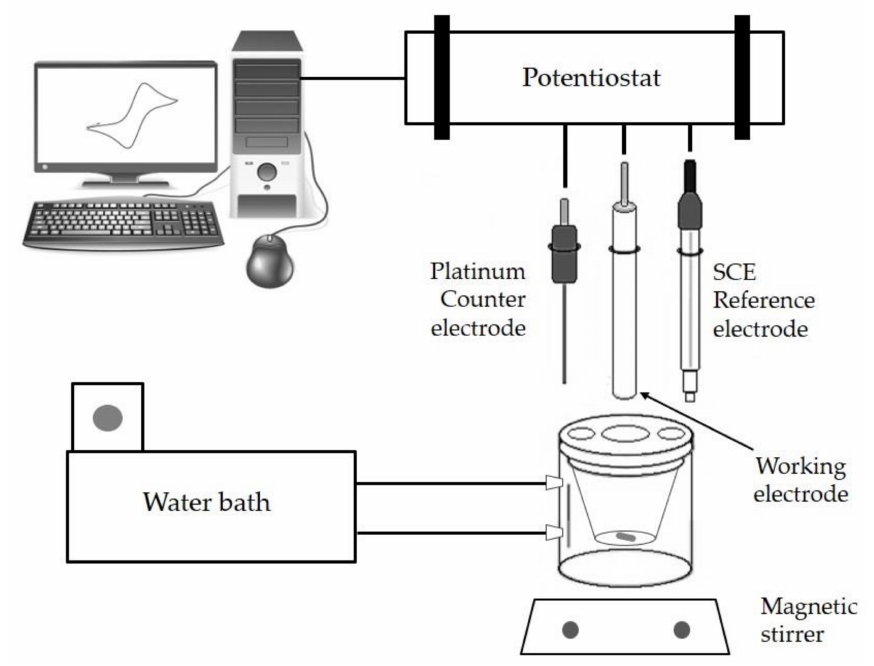
Figure 1. Experimental setup